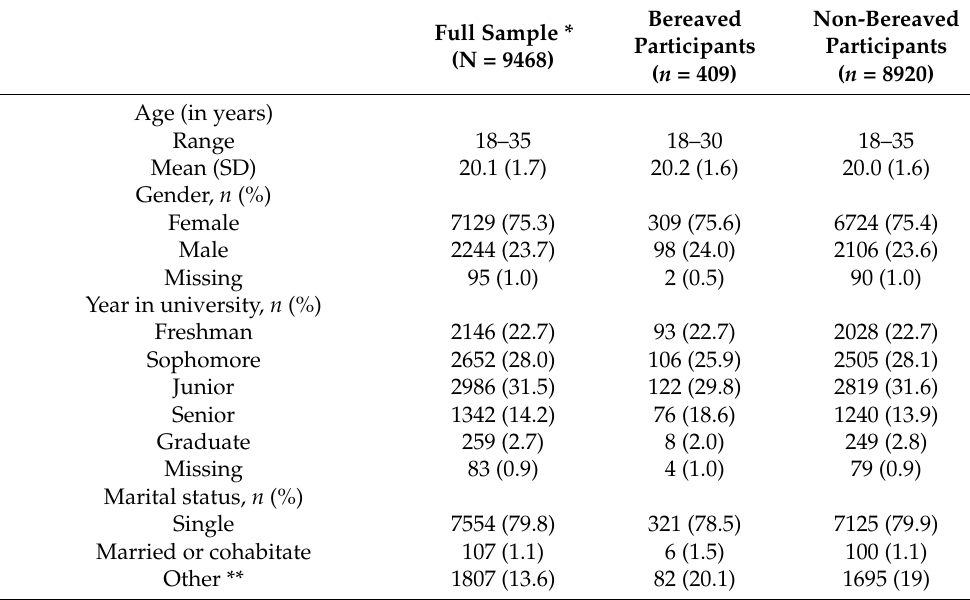
Table 1. Demographic characteristics of the